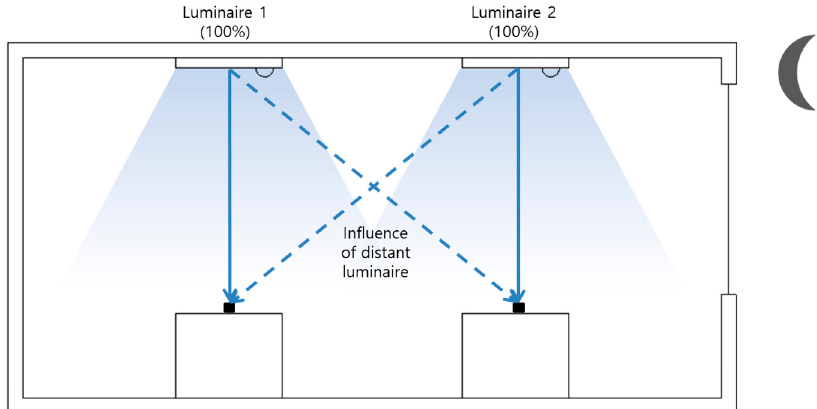
Figure 4. Actual luminous environments affected by the nearest and the distant luminaire.